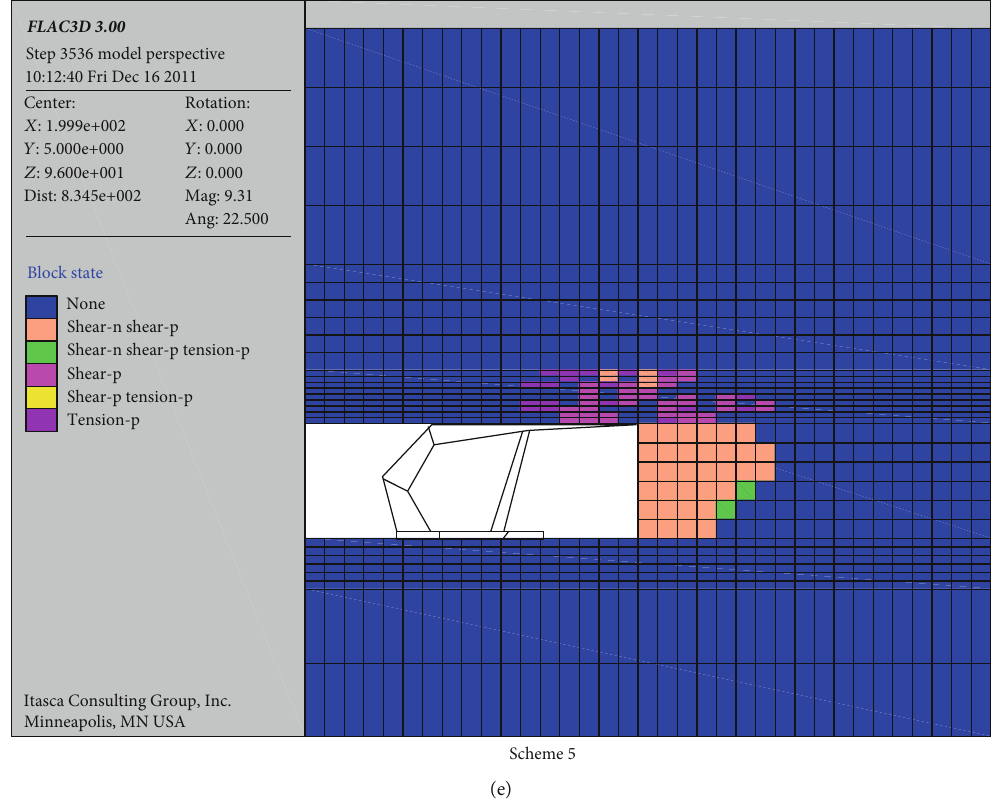
Figure 4: Numerical simulation